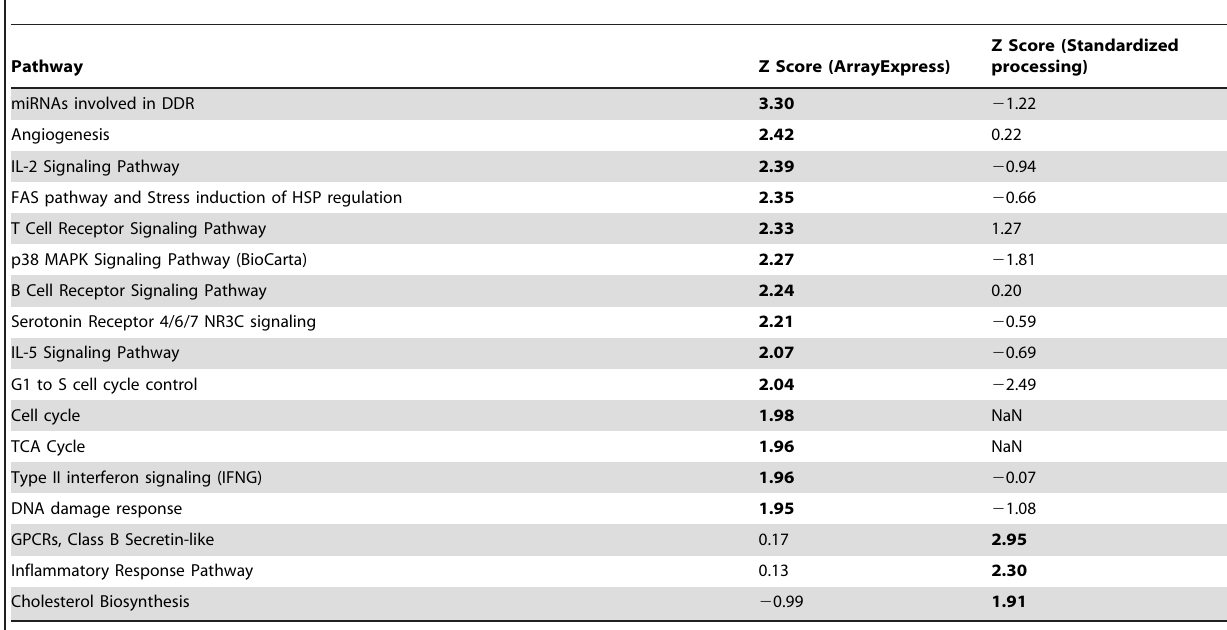
Table 5. PathVisio results of significant pathways found in the dataset by Sun et al. comparing processed data provided by ArrayExpress with the reprocessed data after quality